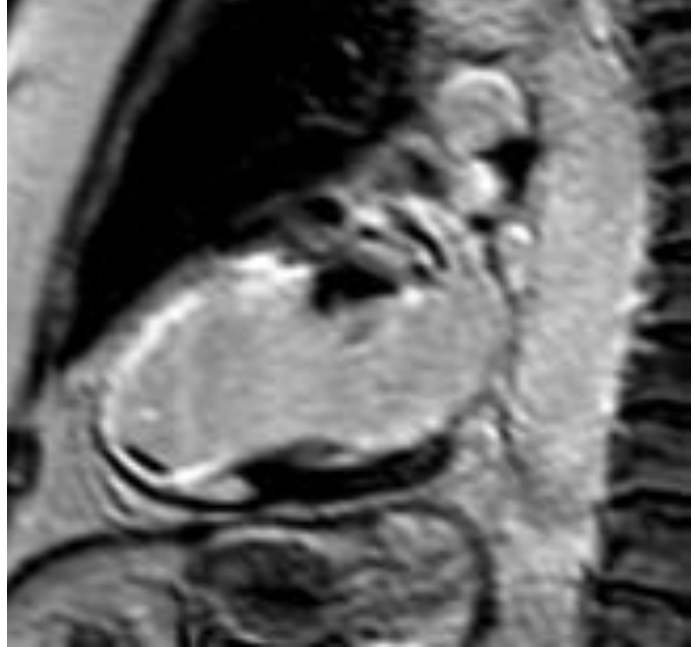
Figure 1. ‘’Bright is dead’’. Inversion recovery image showing extensive LGE area due to anterior myocardial infarction. During late imaging, a gadolinium-based contrast agent (GBCA) is present in areas of fibrosis, as mentioned in the text. Τhe bright area in the anterior and apical wall represents scar tissue.